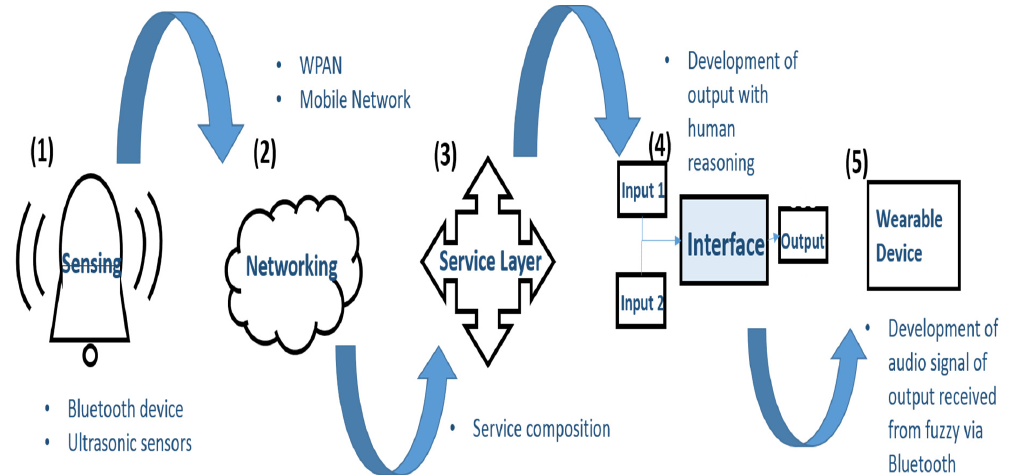
Figure 3. System flow diagram for final output generation.